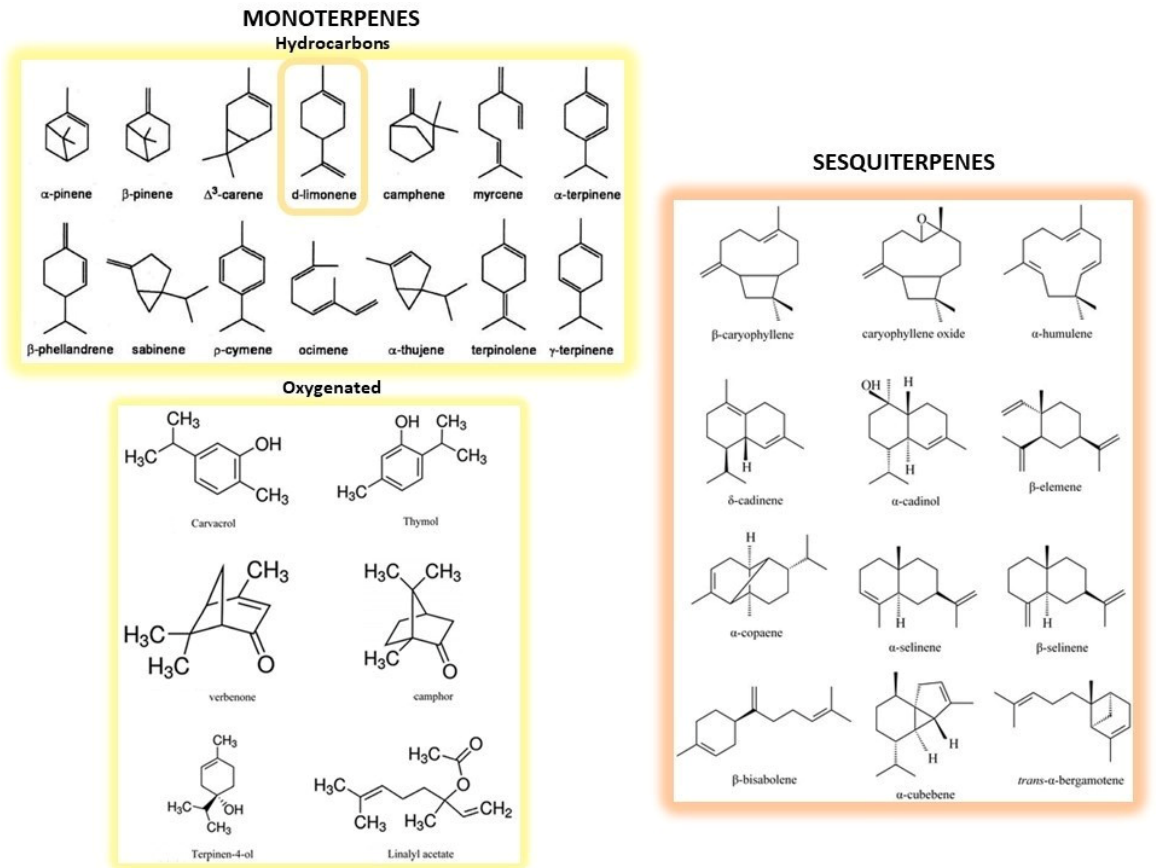
Figure 1. Structures of the main monoterpenes and sesquiterpenes present in CF peels. Monoterpenes represent the simplest terpenes, with two isoprene units and ten carbon atoms. They are divided into hydrocarbons (on the upper left ) and oxygenated derivatives (on the lower left ). Among the former, d-limonene (circled) is the main constituent of essential oils. Sesquiterpenes (on the right ) are more complex terpenes possessing three isoprene units and fifteen carbon atoms.